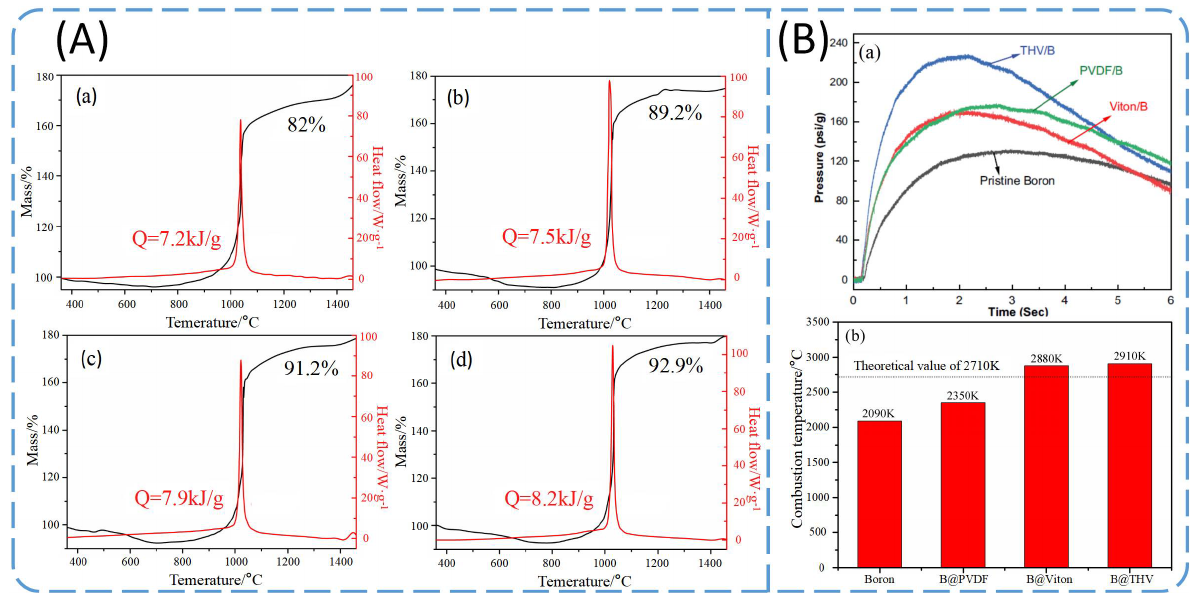
Figure 13. ( A ) TG and DSC curves of ( a ) raw boron; ( b ) B@PVDF; ( c ) B@Viton, and ( d ) B@THV; ( B ) ( a ) pressure curves of closed burner and ( b ) combustion temperatures in air for raw boron and fluoropolymer - coated boron powder [97].